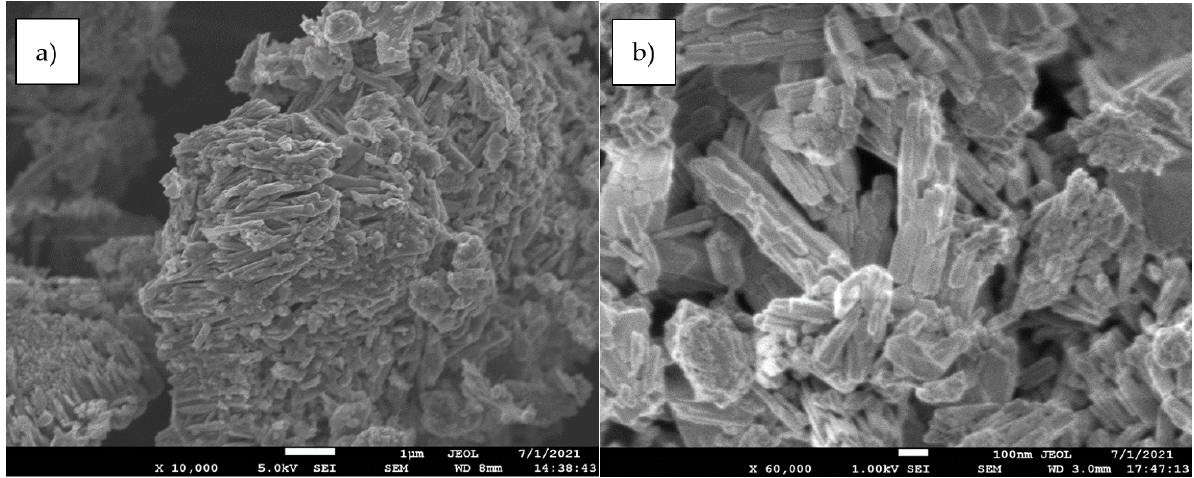
Figure 8. Goethite crystals observed by scanning electron microscopy (SEM). ( a ) general appearance of grain and ( b ) magnification (×60,000).